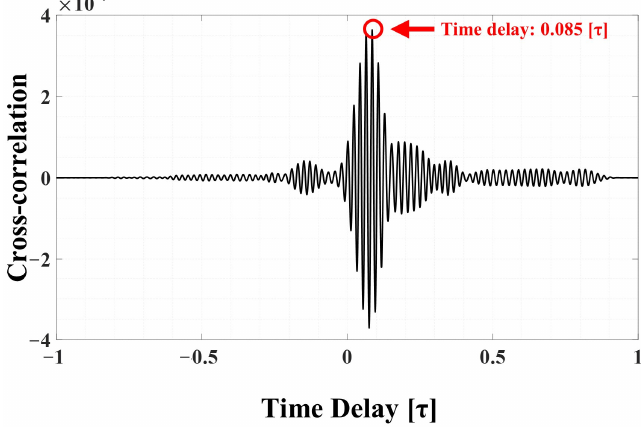
Figure 18. Cross-correlation results using the fi ltered signals.